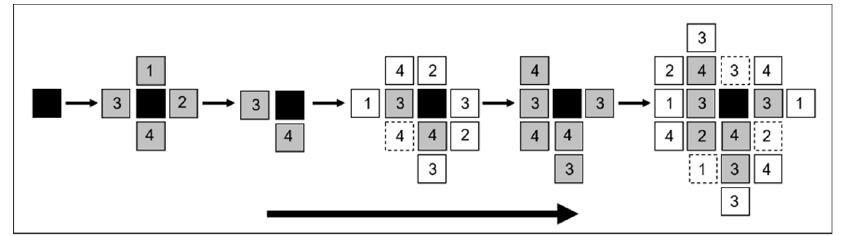
Figure 5. Process for constructing a patch using Patch-Growing Process (PGP) algorithm. Cells show the suitability value to recover agrarian lands.